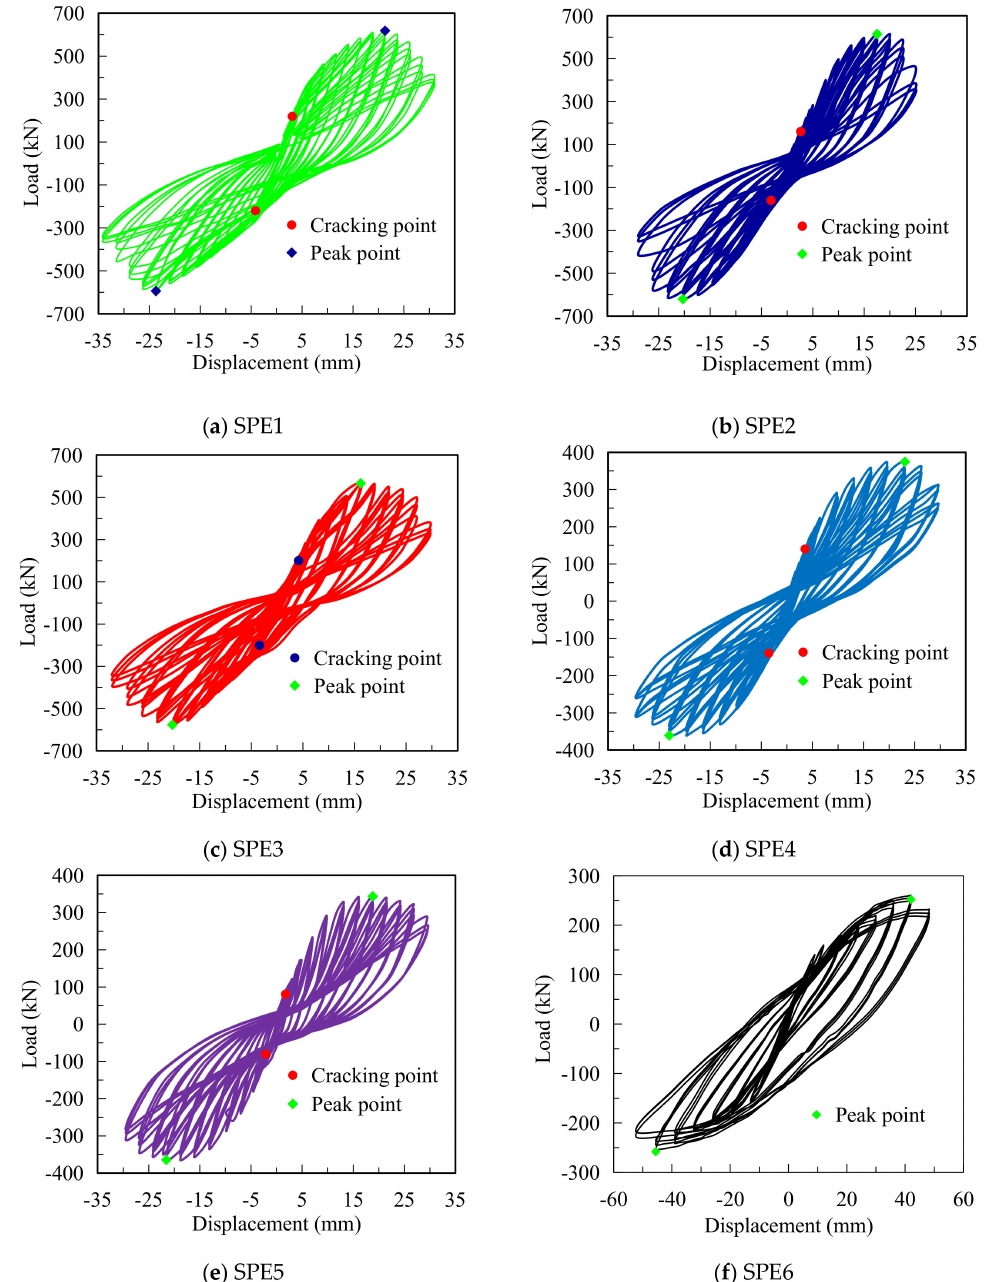
Figure 11. Hysteretic curves.